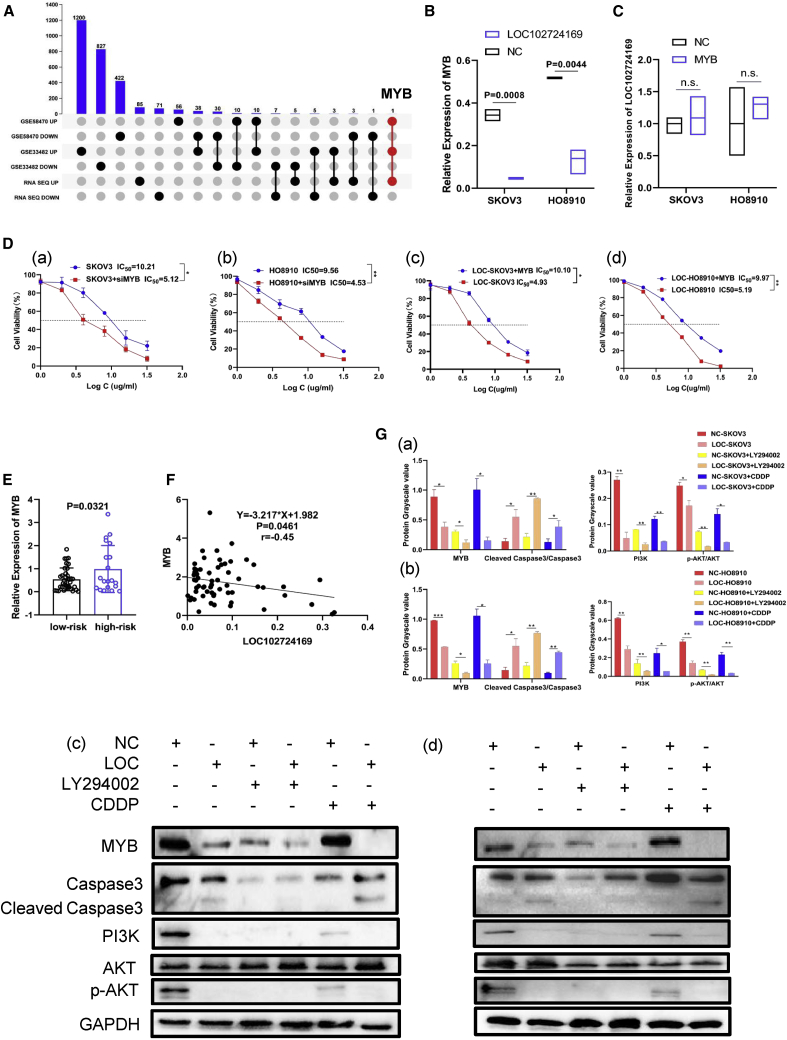
LOC102724169 regulated the expression of MYB and affected the PI3K/AKT pathway in OCCS(A) Schematic overview of the workflow used to investigate the target gene of LOC102724169 in OCCS. (B) Relative expression of MYB in both SKOV3 and HO8910 cells transfected with LOC102724169 or control plasmid. (C) Relative expression of LOC102724169 in both SKOV3 and HO8910 cells transfected with MYB or control plasmid. (Da and Db) Knockdown of MYB decreased the IC50 values of cisplatin in SKOV3 and HO8910 cells. (Dc and Dd) Overexpression of MYB in LOC-SKOV3/HO8910 cells increased the IC50 values of cisplatin. (E) Validation of MYB expression between the high-risk stress group and low-risk stress group. (F) Correlation analysis of MYB and LOC102724169 expression levels by a Pearson correlation coefficient (r = −0.45, p = 0.0461). (Ga and Gb) Histograms represent the quantification of western blot bands in both SKOV3 and HO8910 cells. (Gc and Gd) Western blot analysis of MYB, caspase-3, and PI3K/AKT signaling-related molecule expression in different groups in both SKOV3 and HO8910 cells. ∗p < 0.05, ∗∗p < 0.01, ∗∗∗p < 0.001. Data are represented as mean ± SEM.